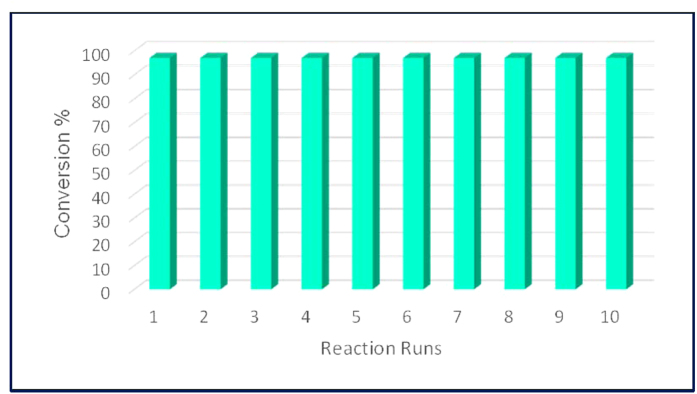
Investigation of the catalysis performance in 10 runs.(Reaction conditions: 0.1 M PhI and 0.25 M K2CO3 in MeOH:H2O 3:1, 0.3 mL.min−1, 5% Pd/C; 2 h each reaction run).